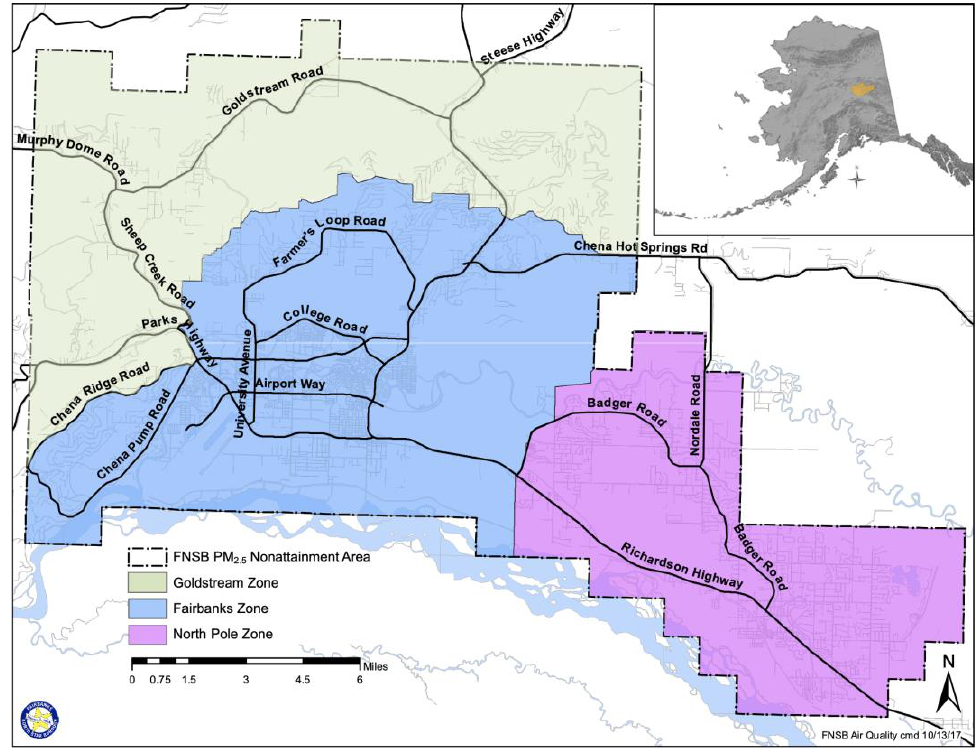
Figure 1. Map of the FNSB with the nonattainment area outlined. A map of Alaska is inset with the FNSB shaded in gold for spatial reference (adapted from FNSB Air Quality burn restriction zones map, 2017).